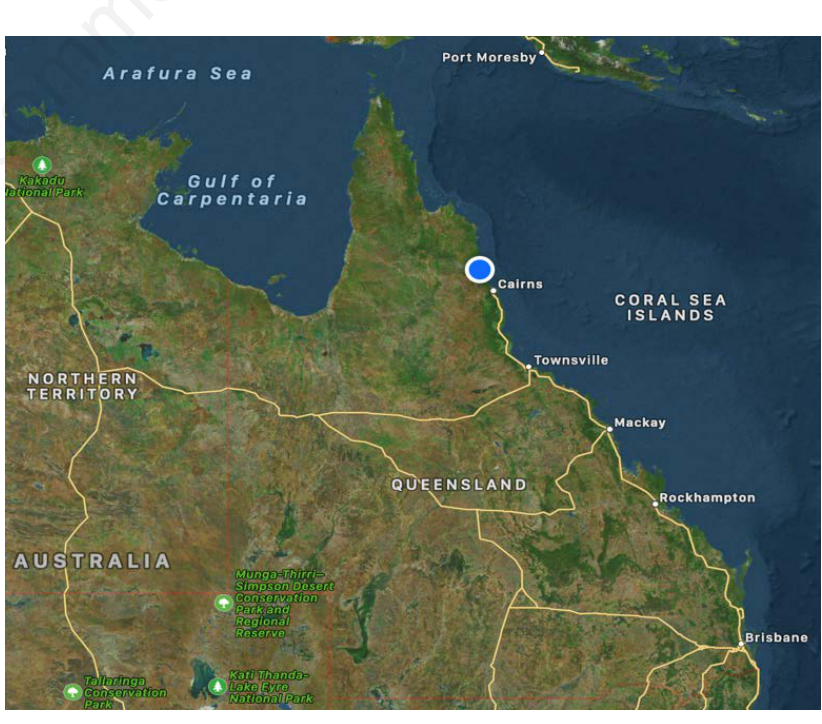
Figure 1. A map of Queensland. The blue dot is the field research area in the vicinity of Wonga Beach (16.35 S). Courtesy Apple